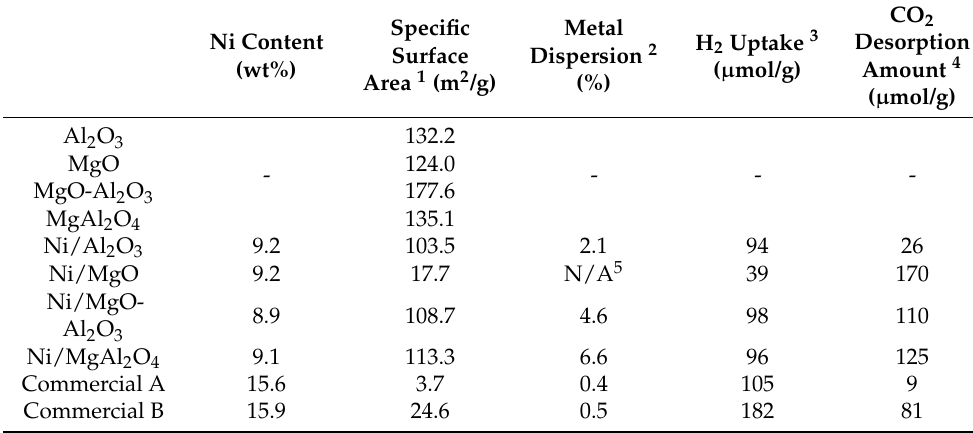
Table 1. Characteristics of supports and Ni-based catalysts.